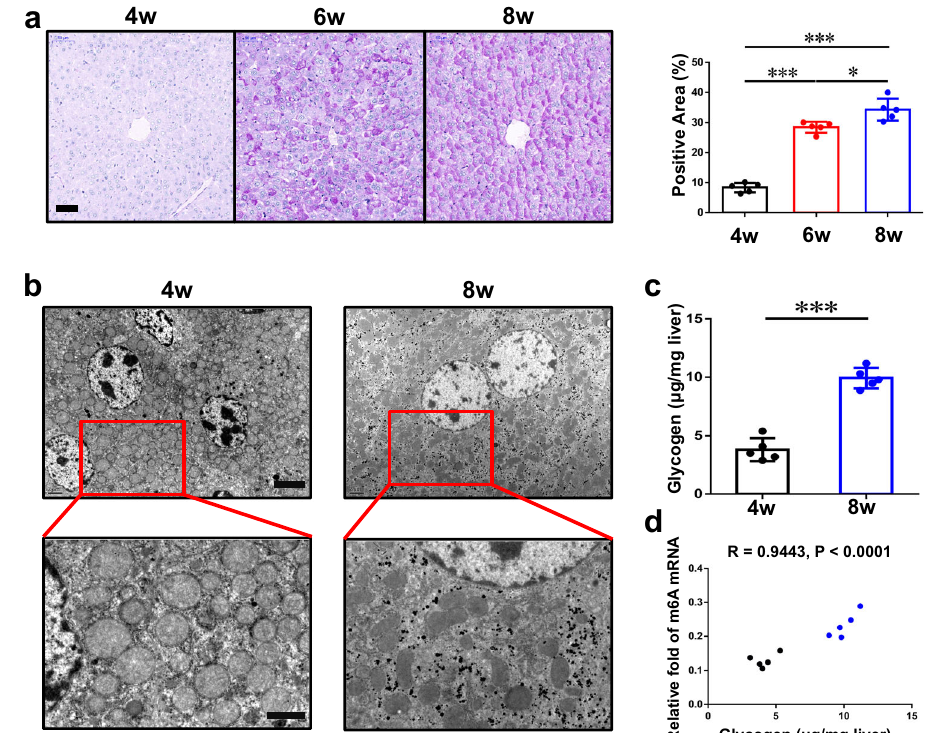
Fig. 1 | Low content of mRNA m6A is related to a shortage of hepatic glycogen in mouse pups. a PAS staining of wild-type mouse livers in different ages (4w, 4weeks;6w,6weeks;8w,8weeks).Thepercentageofpositiveareaismeasuredby Image J and shown on the right. Bar, 50 μ m. n =5 animals. Data are presented as mean values+/ − SEM. * p <0.05; *** p <0.001 by one-way ANOVA. b Transmission electron microscope pictures of wild-type mouse livers in different ages. Bar: top, 4 μ m; bottom, 2 μ m. This experiment was repeated independently with similar